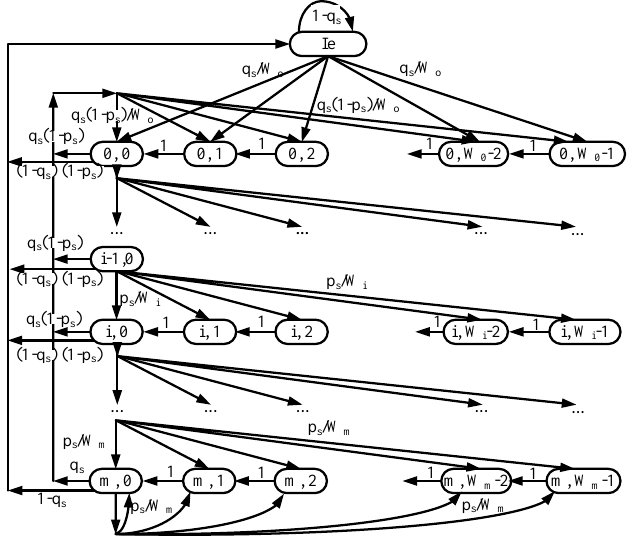
Figure 4. Markov chain of the WSA